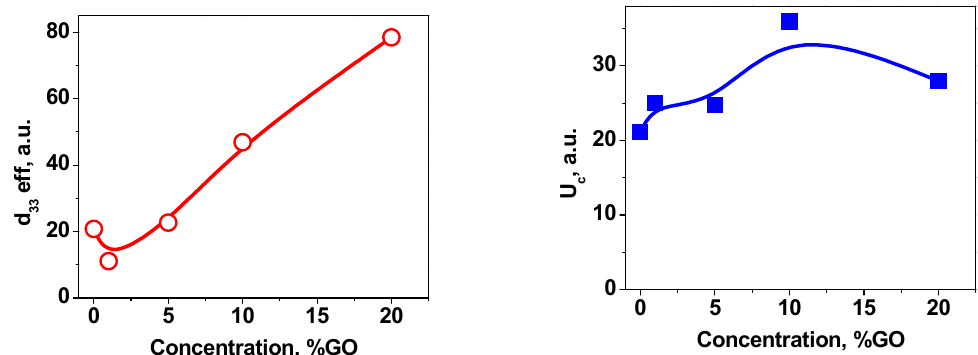
Figure 7. Concentration dependences of switching parameters of P(VDF-TrFE)-graphene oxide fibers with different concentration of GO. Table 1. Concentration dependence of piezoelectric coefficient of P(VDF-TrFE)-graphene oxide fibers with different concentration of GO.